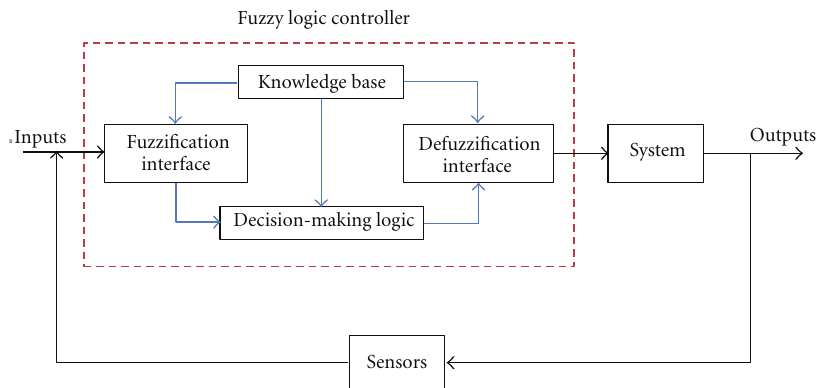
Figure 3: Fuzzy logic control system.